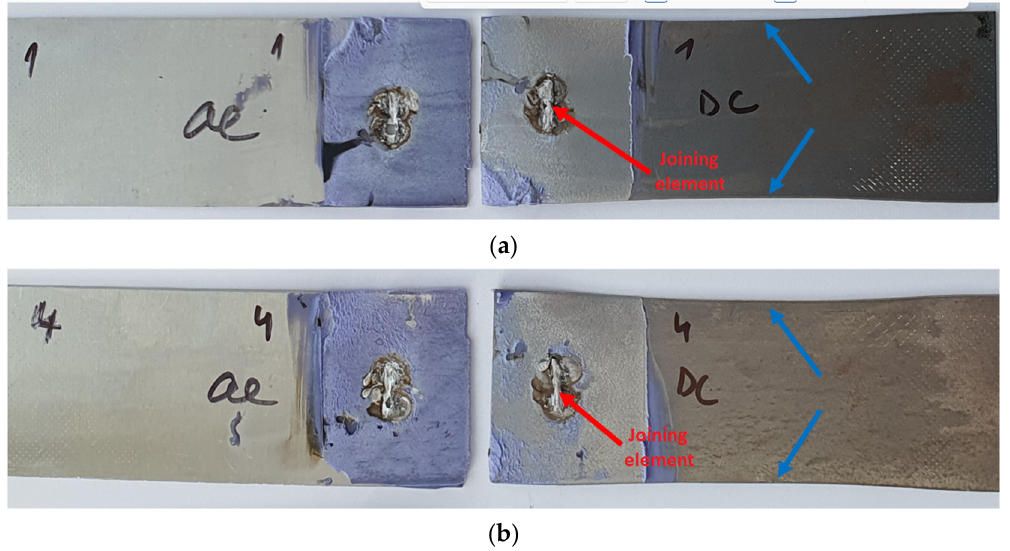
Figure 16. Fracture surfaces of Al-DC test joints made by resistance spot welding and AB after tensile shear test: ( a ) sample 1 and ( b ) sample 4, epoxy based adhesive.